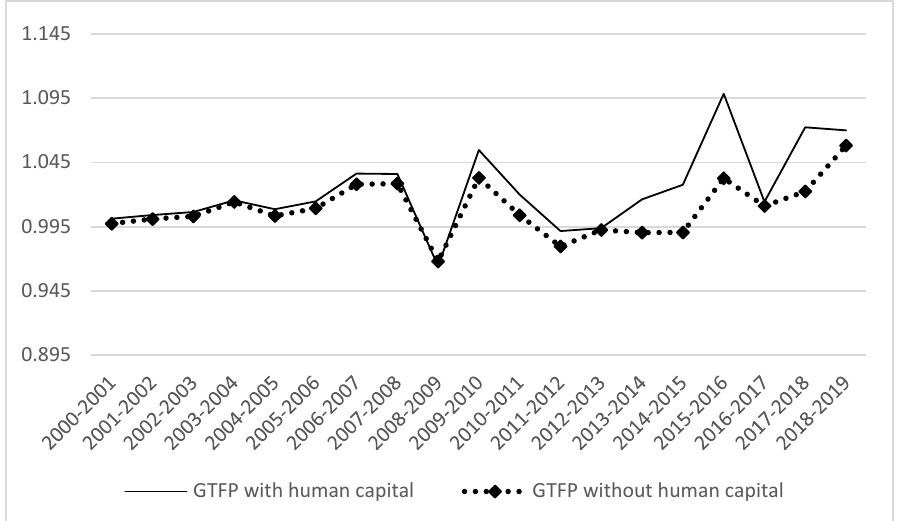
Figure 2. Comparison of GTFP in two modes.